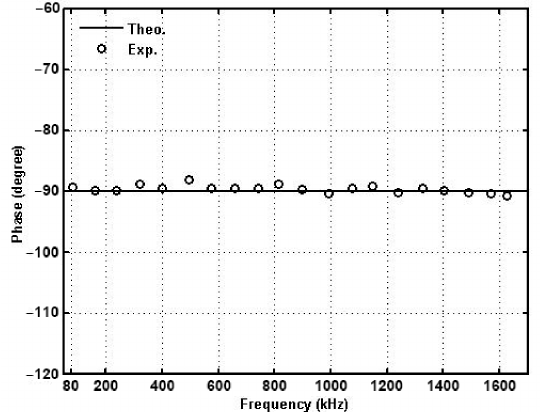
Figure 46. The measured phase difference of quadrature output voltages V o4 and V o5 versus the tuning FO.